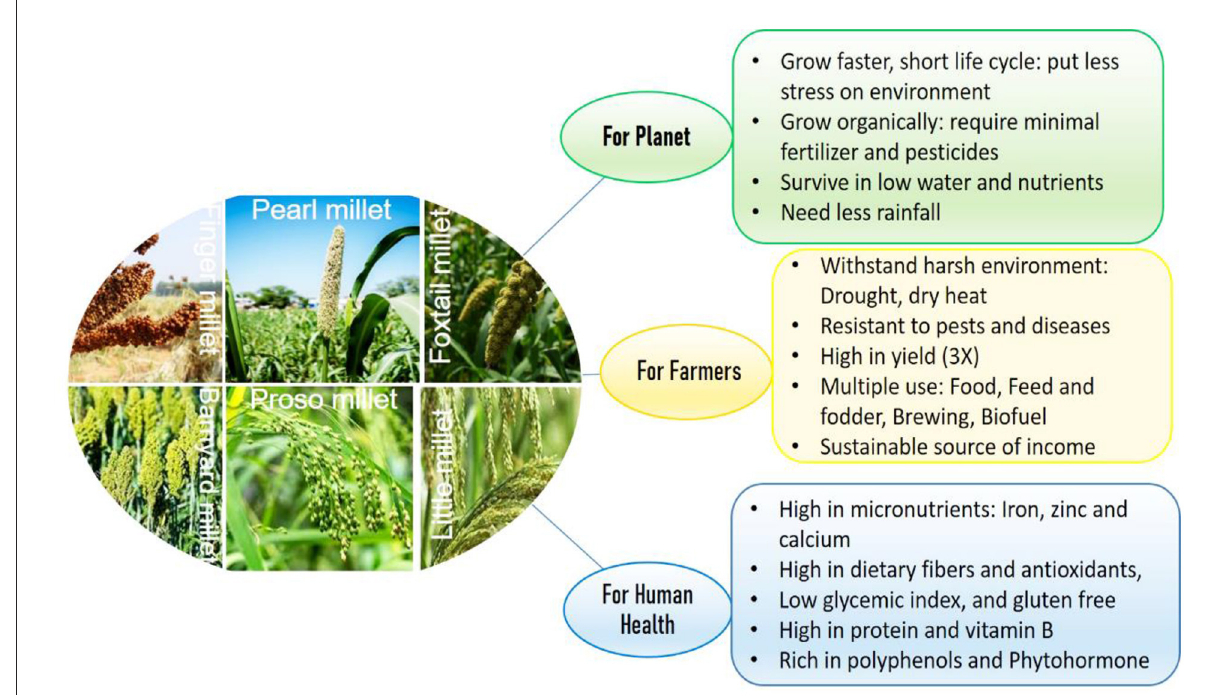
FIGURE1 Unique properties of millets for climate smart agriculture, ensuring human health, food and nutritional